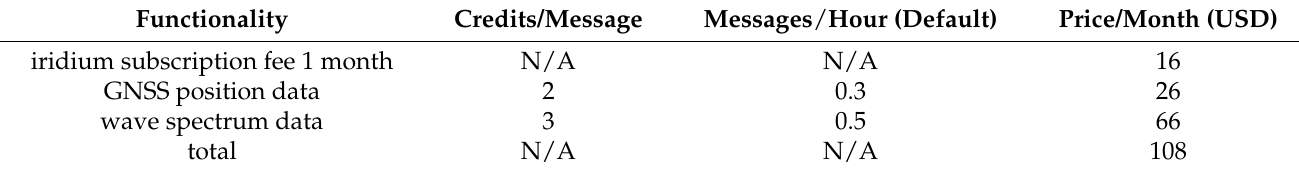
Table 3. Overview of the Iridium communication costs. The prices correspond to the ones offered by RockSeven at the time of writing this manuscript. It is possible to modify the rate of data collection by either using different setups when one programs the instrument firmware, or by sending a measurement rate update command to the instrument through